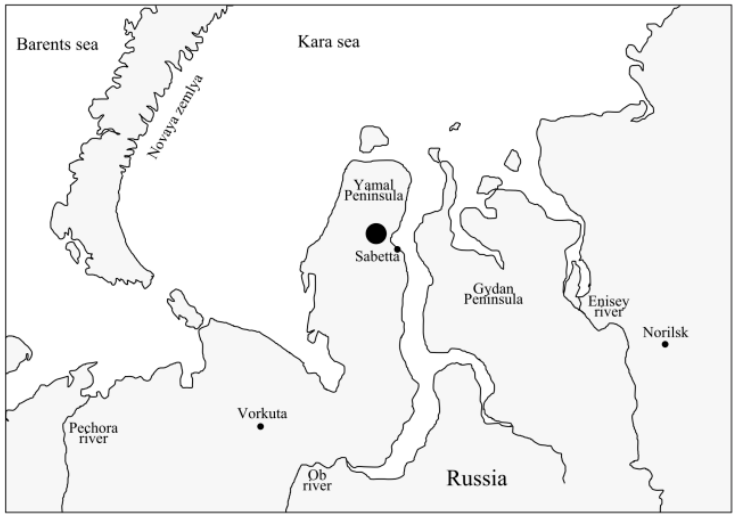
Figure 1. Locality of Ch. laetus and Ch. laetus × Ch. sp. Le1 in the Yamal Peninsula, Russia. The collection site is marked by a big black circle.